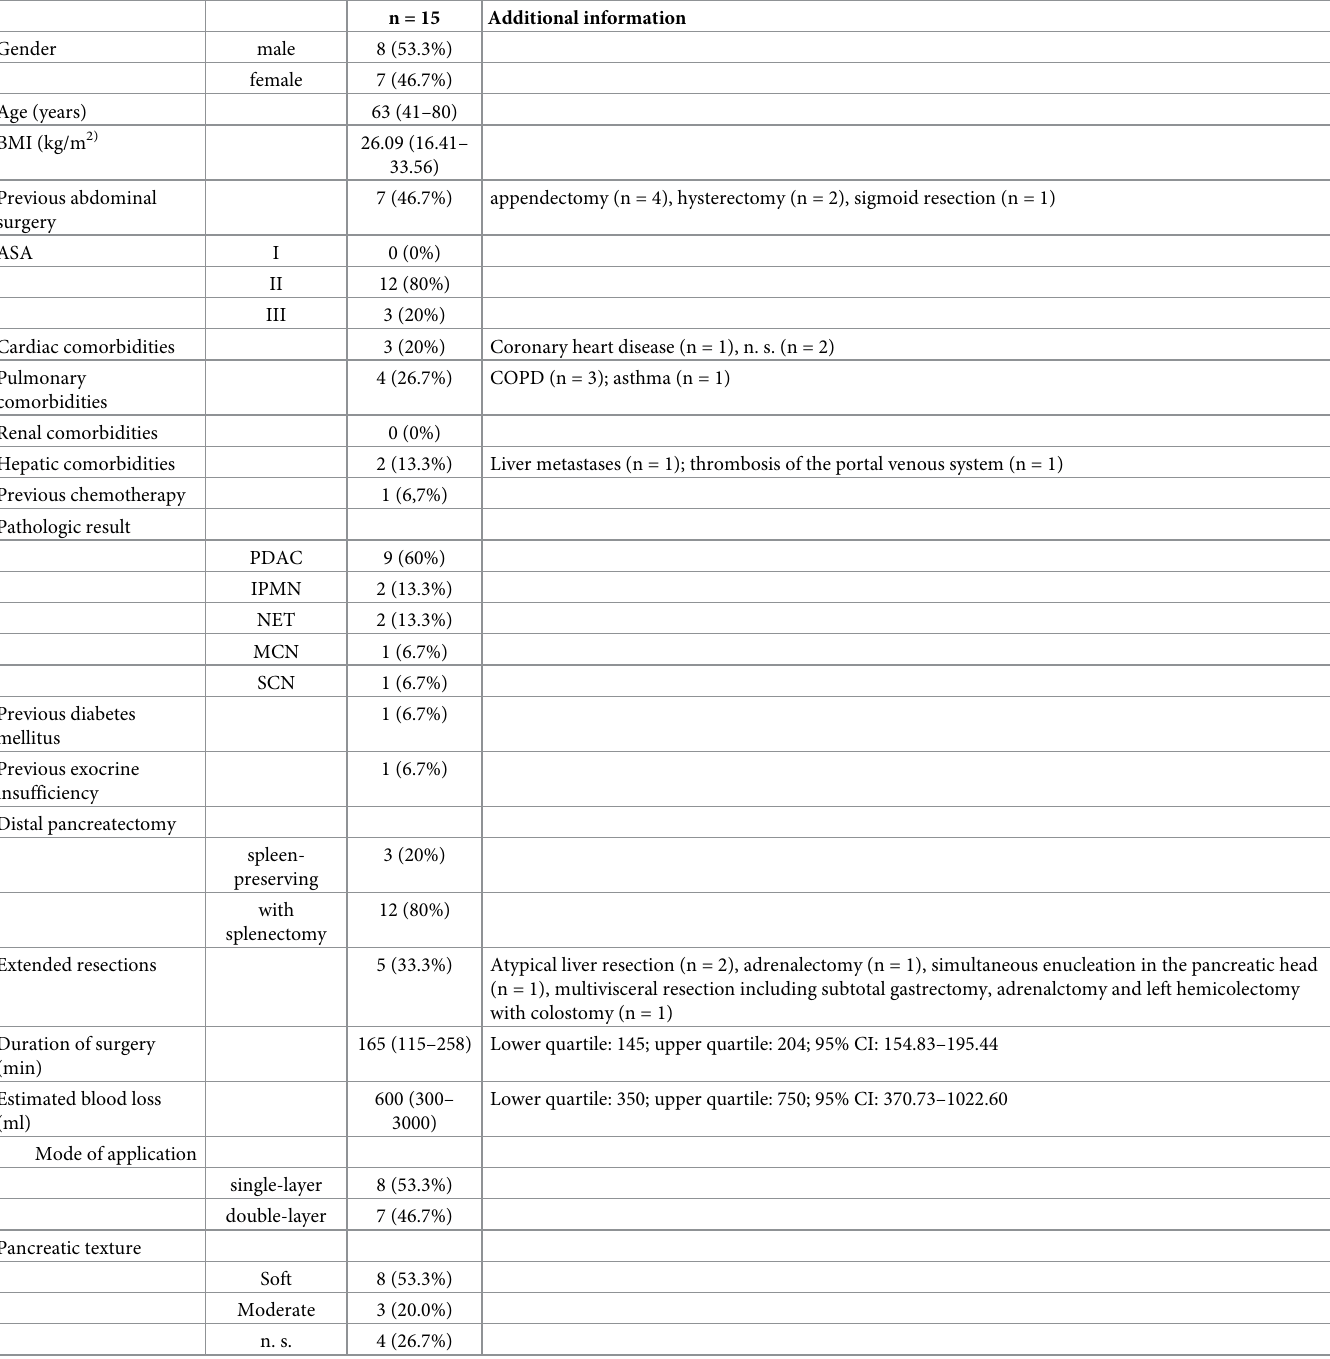
Table 2. Baseline characteristics of the study population and intraoperative